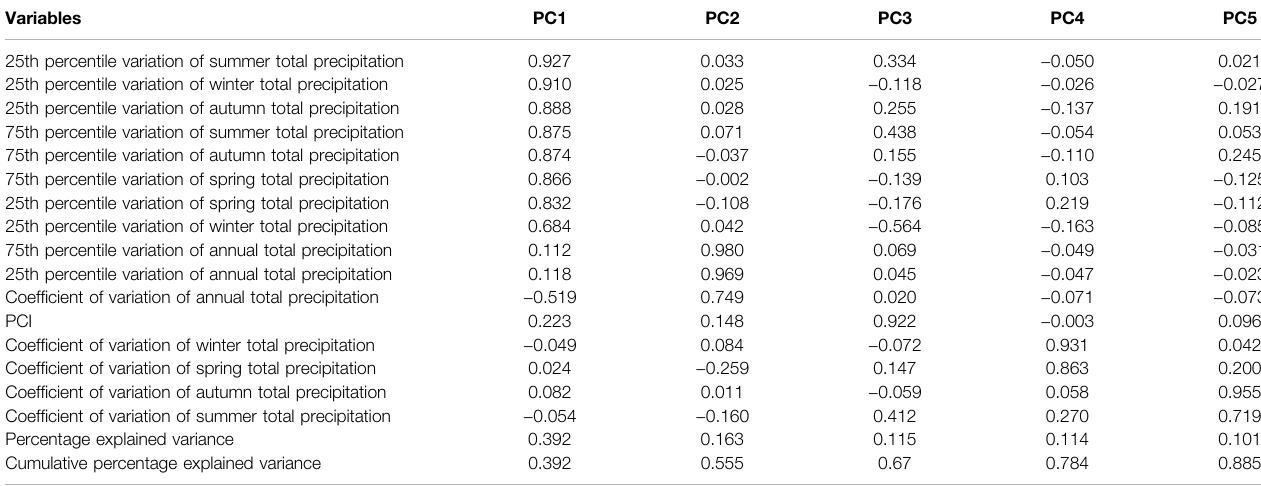
TABLE 3 | Summary of principal component analysis.